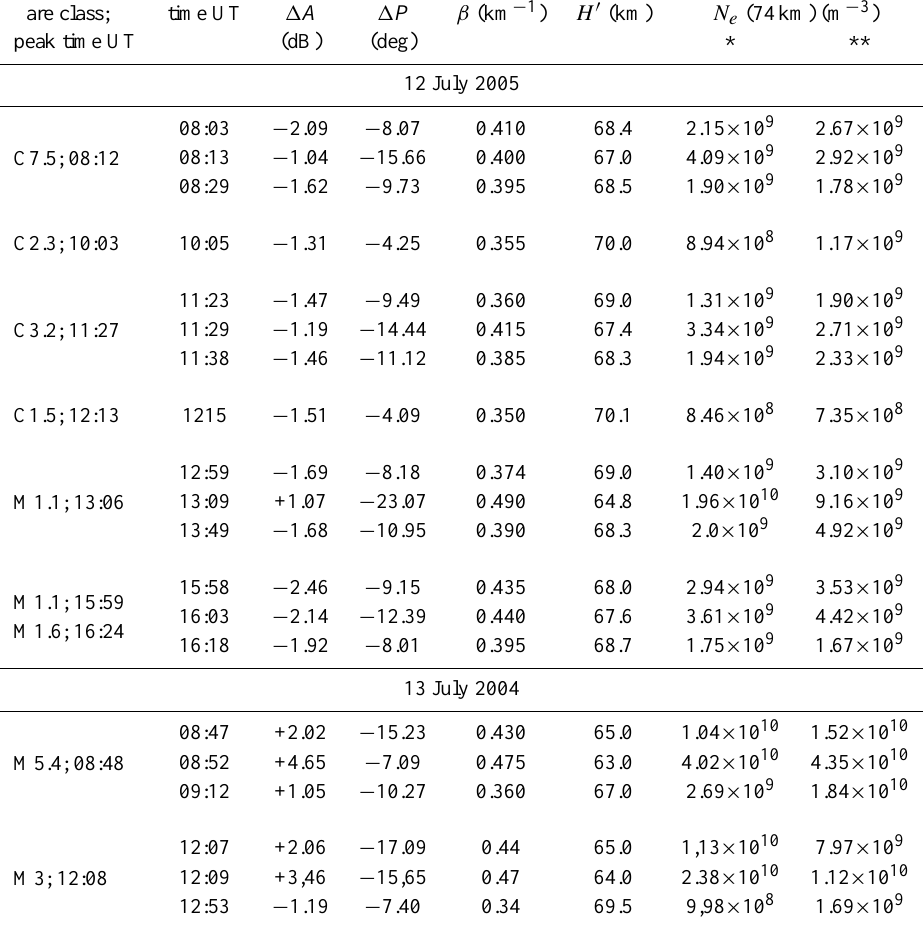
Table 1. Measured amplitude and phase perturbations, deduced β and H 0 and electron densities N e , at different stages of flare occurrence: present study* and ˇZigman et al.